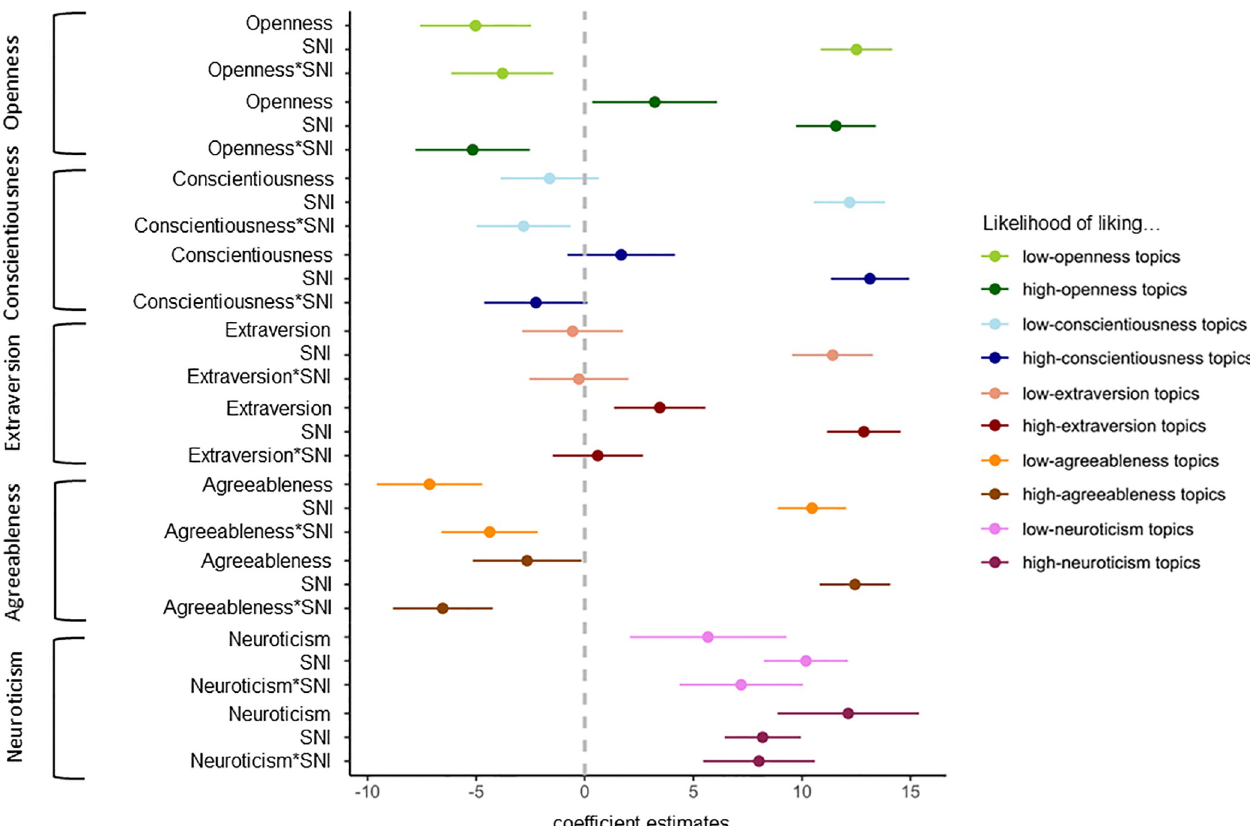
Fig 2. Coefficient estimates for the regression analyses with SNI and the Big Five personality traits on Facebook liking behavior. An overview of the coefficient estimates with the CIs for the 10 regression analyses is as follows: (1) likelihood of liking low-openness topics = Openness � SNI (2) likelihood of liking high-openness topics = Openness � SNI (3) likelihood of liking low-conscientiousness topics = Conscientiousness � SNI (4) likelihood of liking high- conscientiousness topics = Conscientiousness � SNI (5) likelihood of liking low-extraversion topics = Extraversion � SNI (6) likelihood of liking high- extraversion topics = Extraversion � SNI (7) likelihood of liking low-agreeableness topics = Agreeableness � SNI (8) likelihood of liking high-agreeableness topics = Agreeableness � SNI (9) likelihood of liking low-neuroticism topics = Neuroticism � SNI (10) likelihood of liking high-neuroticism topics = Neuroticism � SNI. Regarding the aim of Study 3, it should be noted that all 10 regression analyses revealed a conditional effect of SNI, substantiating that SNI drives OSN users to like what others in OSNs like. Furthermore, the depicted coefficient estimates for the interactions show that there is only partial support for the idea that SSI moderates the effect of the Big Five personality traits on OSN